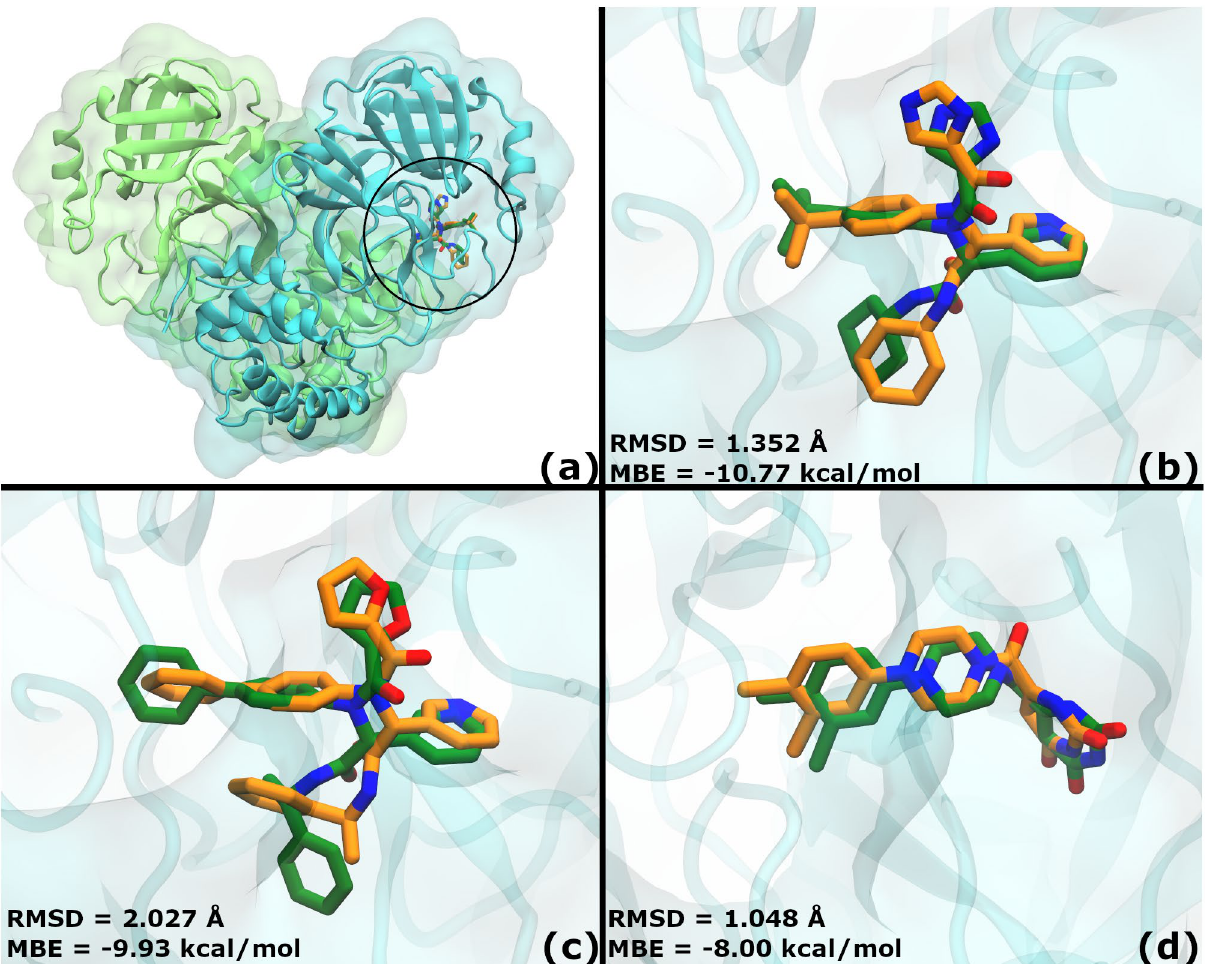
Figure 2. Structural alignment between positive controls and the original M PRO crystal. Docked non-covalent inhibitors X77 (PDB ID: 6W63) 48 , X7V (PDB ID: 7KX5) 49 and YD1 (PDB ID: 7LTJ) 50 were aligned to their original M PRO crystals. Docking was carried out following the exhaustive-ranking procedure using AutoDock- GPU. RMSD was calculated without considering hydrogen atoms. ( a ) Representative ligand X77 in the substrate binding site (black circle). All controls were also bound to this region. The M PRO crystal is shown as in Fig. 1. Ligands are shown in sticks: orange for the control and green for the cross-docked inhibitors. Non-carbon atoms are coloured following the CPK colouring convention. Close-ups are provided to observe the docked pose in detail compared to the original position: ( b ) X77, RMSD = 1.352 Å, MBE = − 10.77 kcal/mol; ( c ) X7V, RMSD = 2.027 Å, MBE = -9.93 kcal/mol; ( d ) YD1, RMSD = 1.048 Å, MBE = − 8.00 kcal/mol. MBE, Mean Binding Energy. X77 was selected as the positive control for further analysis because it had the best docking corresponding complexes with M PRO (PDB IDs: 6W63 48 , 7KX5 49 and 7LTJ 50 , respectively) and docked against ISBS (Fig. 2a). In all cases, 2Dscore was used to select the binding mode. Structural comparison between these binding modes and the corresponding real conformations revealed high similarity for a cross docking assay (Fig. 2b–d). Root-mean-square deviation or RMSD (without hydrogens) were 1.352, 2.027 and 1.048 Å; while mean binding energies were − 10.77, − 9.93 and − 8.00 kcal/mol for X77, X7V and YD1, respectively. Negative control TDZD-8 was docked against ISBS. The best pose according to the 2Dscore had an energy of − 5.46 kcal/mol. Considering the binding energies reported for the top 5 results for both NSBS and ISBS (Sup- plementary Dataset 4) and the binding energies of selected compounds against SBS (Supplementary Fig. 1), it was concluded that negative control was filtered by the exhaustive-ranking protocol. Molecular dynamics of apo protein structures. Molecular Dynamics (MD) of apo M PRO (PDB ID: 6LU7) 34 as a monomer and as a dimer were conducted for 600 ns. RMSD plots (Supplementary Fig. 3a) showed that dimeric M PRO stabilizes at 120–130 ns, whereas monomeric M PRO did so at nearly 290–310 ns. SBS residues only reached convergence in the dimer conformation, at around 2.9–3.1 Å (Supplementary Fig. 3b-c). Also, they were restrained in dimeric M PRO (Supplementary Fig. 3d).